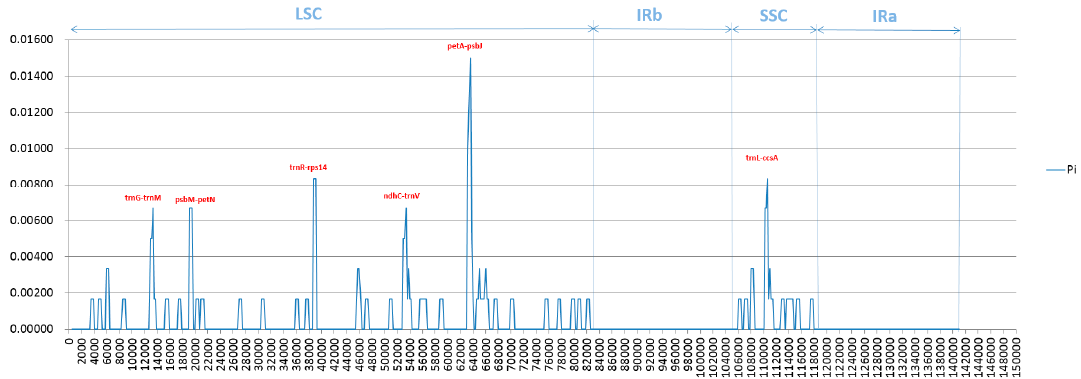
Figure 4. Nucleotide diversity (Pi) based on sliding window analysis in the aligned complete chloroplast genomes of Saccharum officinarum and S. spontaneum . Performing sliding window analysis with: window length 600 bp, step size 200 bp.